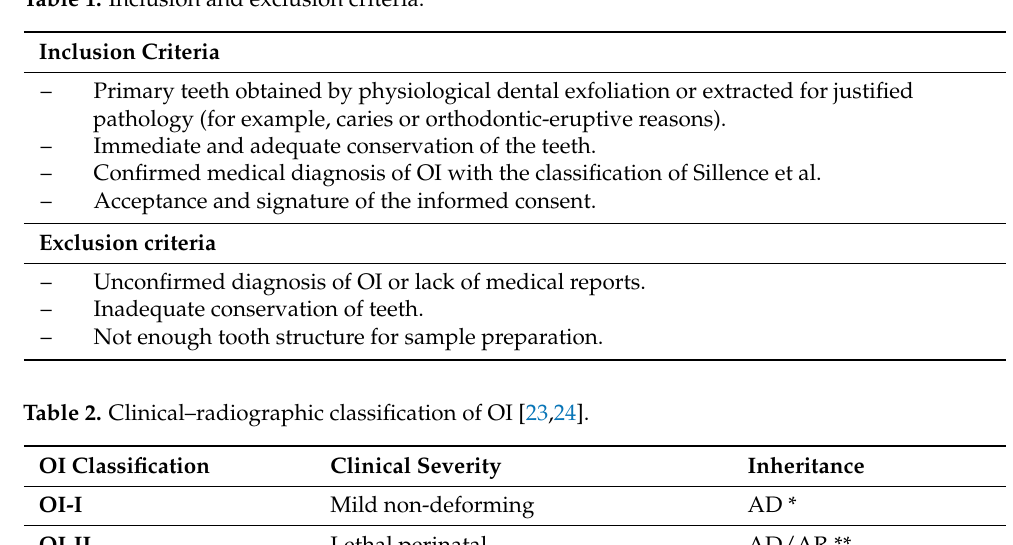
Table 1. Inclusion and exclusion criteria.